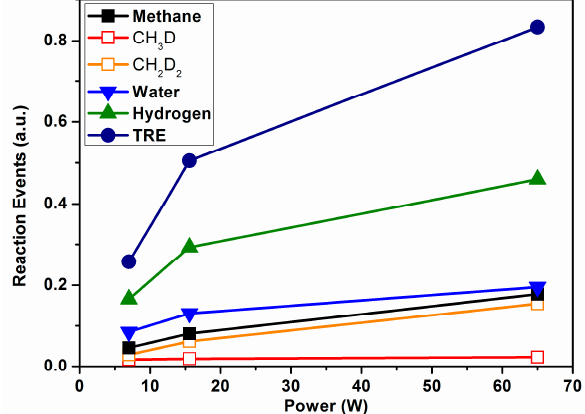
Figure 4. Evolution of REs and TRE for Reaction (2) as a function of plasma power.